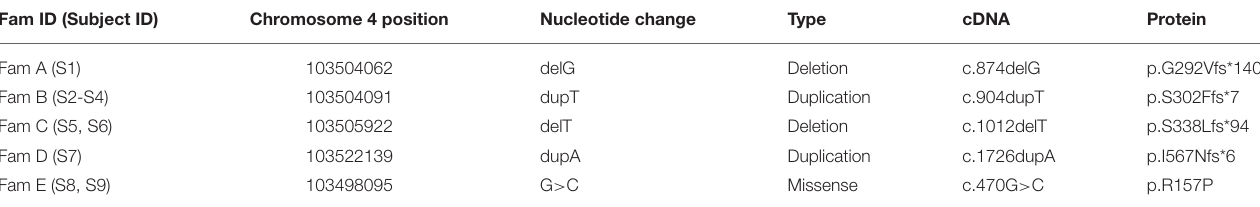
TABLE 3 | Summary of the NFKB1 variants identified in our